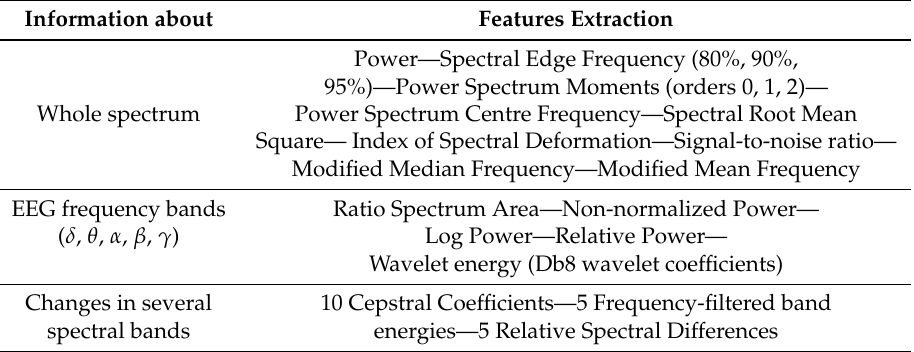
Table A2. Features extracted from the frequency